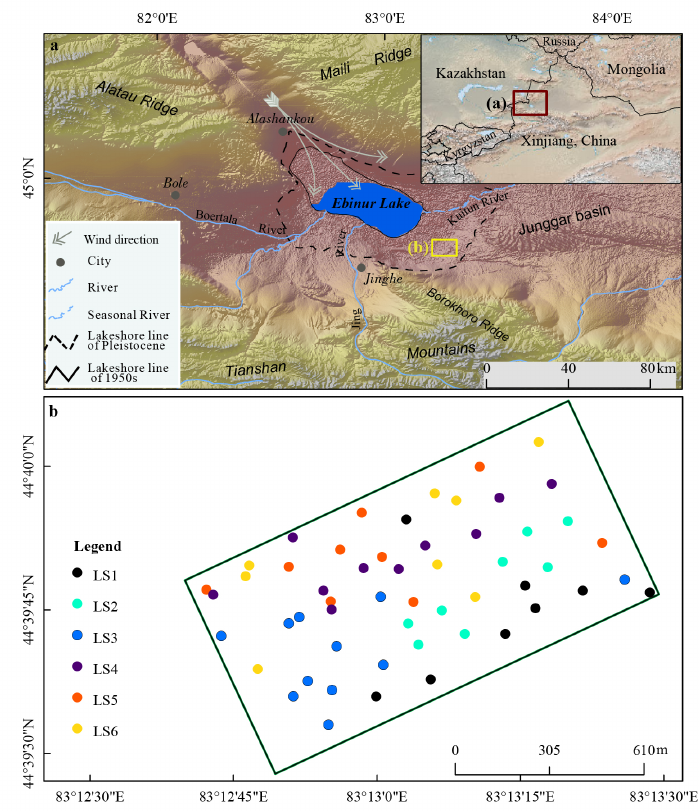
Figure 1. Geographical location of the Ebinur Lake and sample